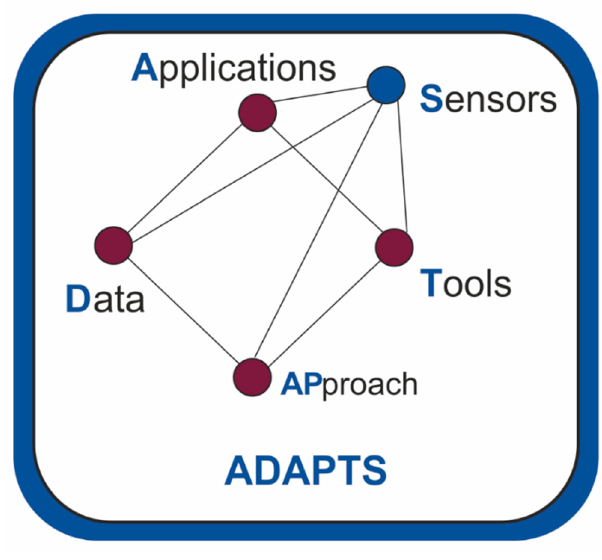
Figure 9. Proposed conceptual framework.